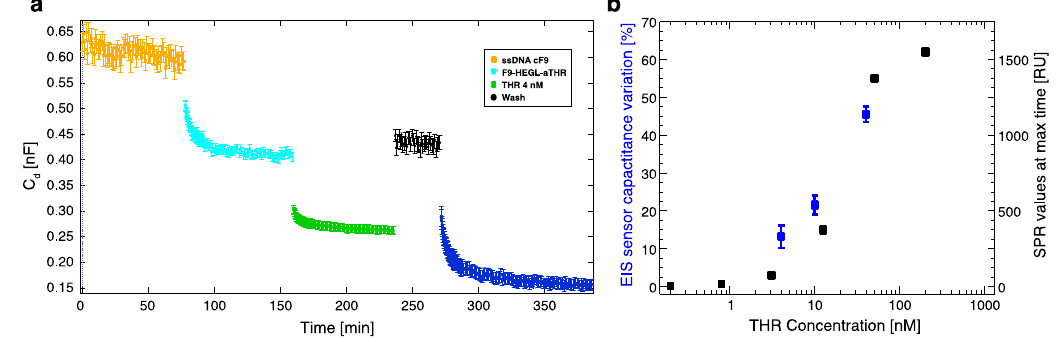
Figure 6. ( a ) Capacitance measured with the EIS setup at different steps of the immobilization; and ( b ) comparison of data obtained from the capacitance variation measured with the EIS setup (left) and SPR data (right) vs. THR concentration.